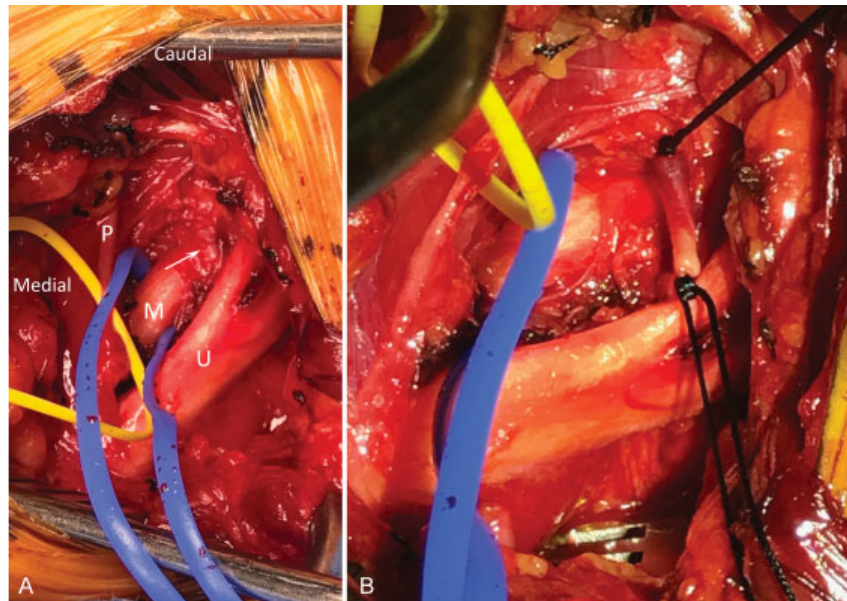
Fig. 2 Second case. ( A ) A vessel (arrow) was found to pass between the middle (M) and upper (U) trunks of the brachial plexus. This was ligated and cut ( B ). P, phrenic